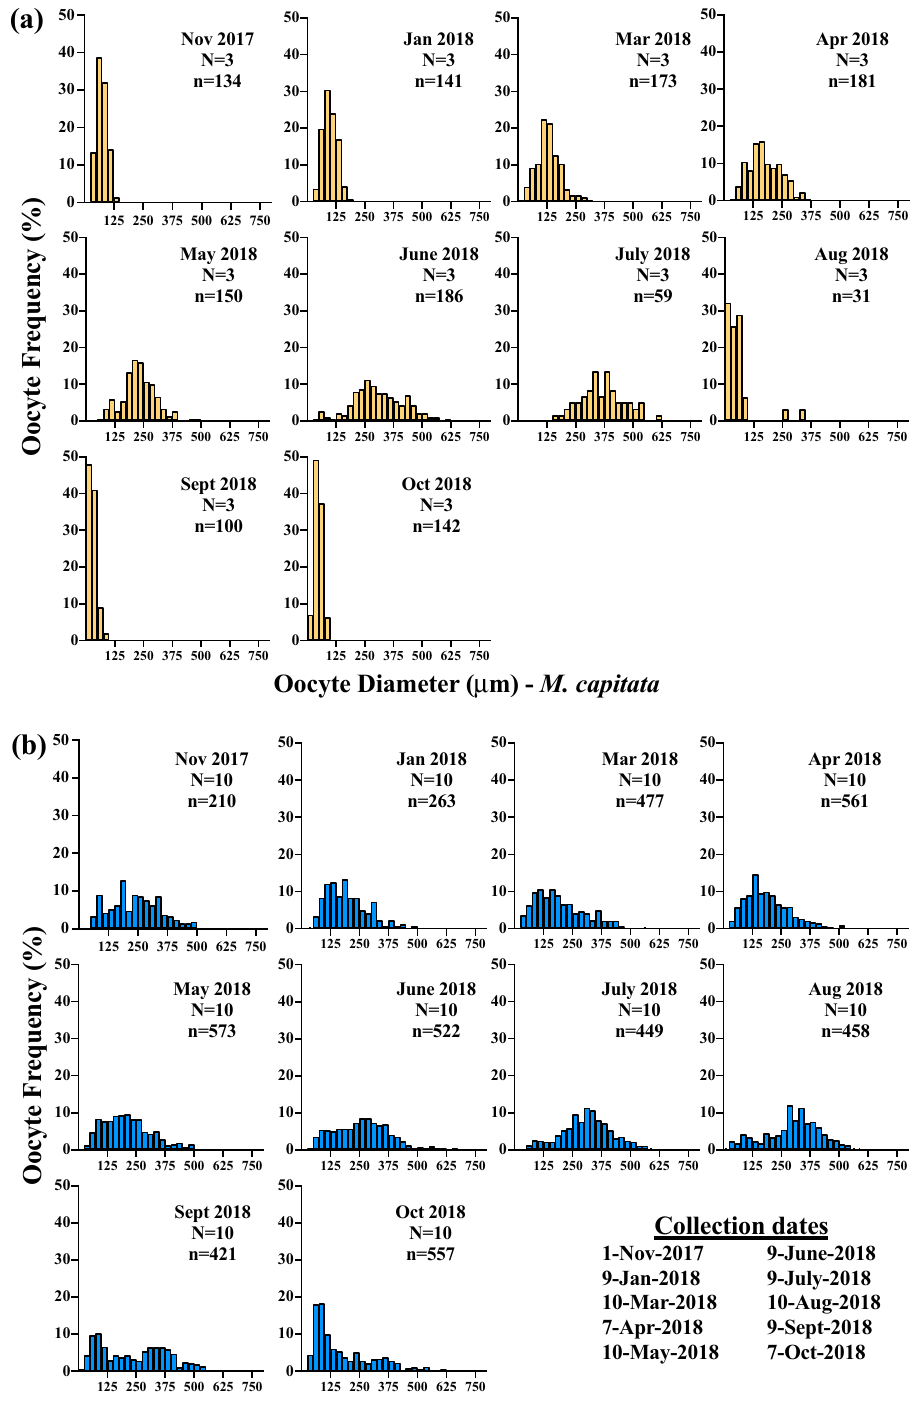
Figure 4. Frequency distribution of oocyte size per month with collection dates. Number of genotypes (N) and number of oocytes (n) analyzed per month for ( a ) M. capitata and ( b ) M. flabellata . Oocyte diameters are binned into 25 μm